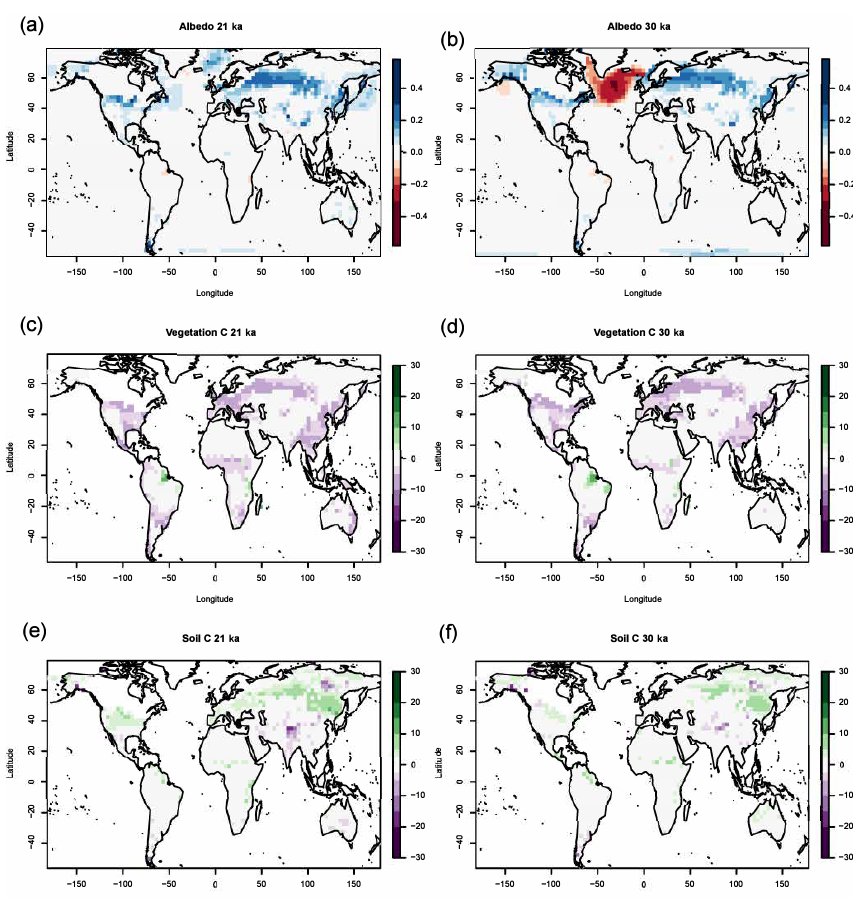
Figure 5. Mean annual anomaly of (a, b) surface albedo (unitless), (c, d) vegetation carbon (kgCm − 2 ), and (e, f) soil carbon (kgCm − 2 ), between the Dynamic vegetation simulation and the equivalent Static vegetation simulation. For 21ka ( a , c , e ) and 30ka ( b , d , f ). The pattern of reduced surface albedo at 30ka is similar to the pattern at 56 and 100ka. Since in the Static simulations the carbon remains at PI levels, panels (c) – (f) also represent the anomaly to PI. The ice sheets are excluded from these plots. For the carbon under ice sheets, see Fig. A4.